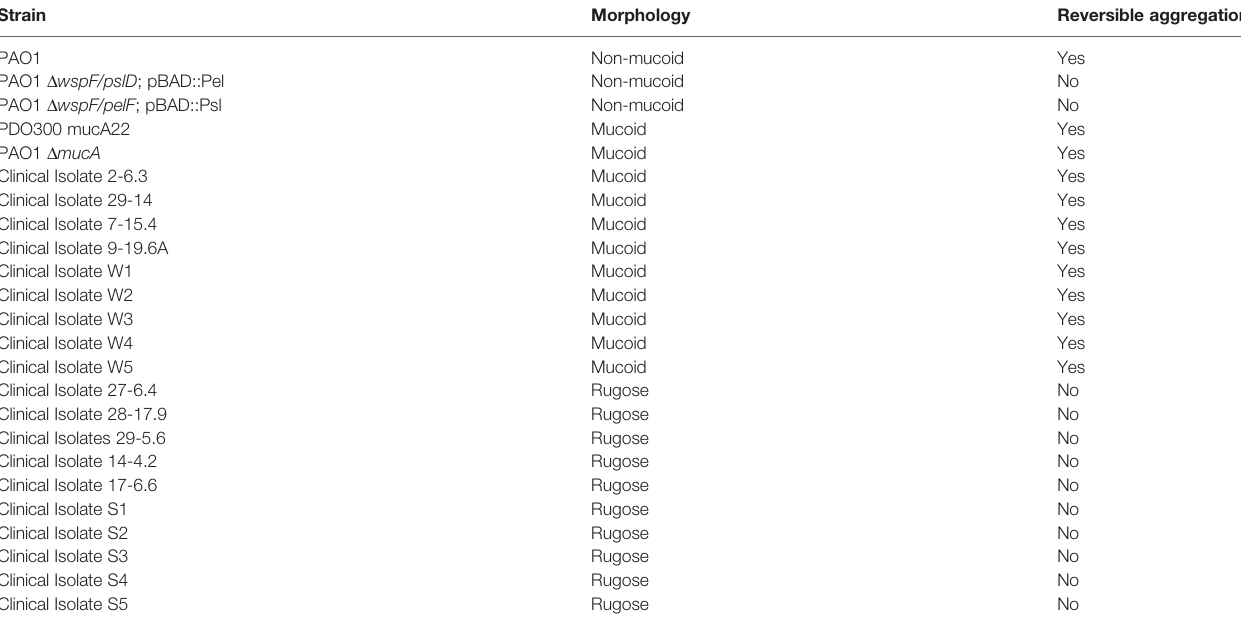
TABLE 2 | P. aeruginosa morphology and aggregate reversibility phenotypes.